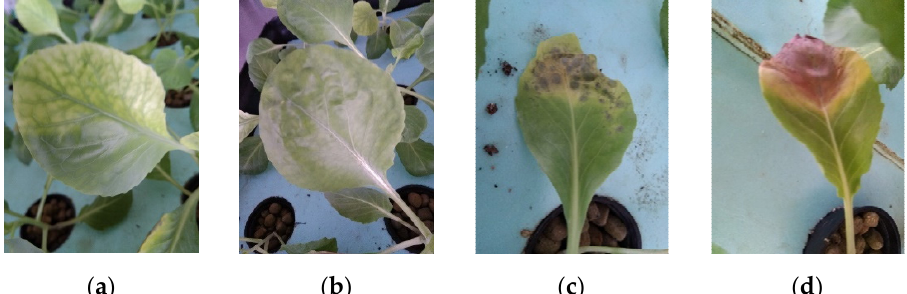
Figure 5. Evidence of nutrient deficiency observed on cabbage leaves: ( a ) leaf yellowing in-between veins; ( b ) leaf blade wrinkling; ( c ) and (d) blade tip necrosis.